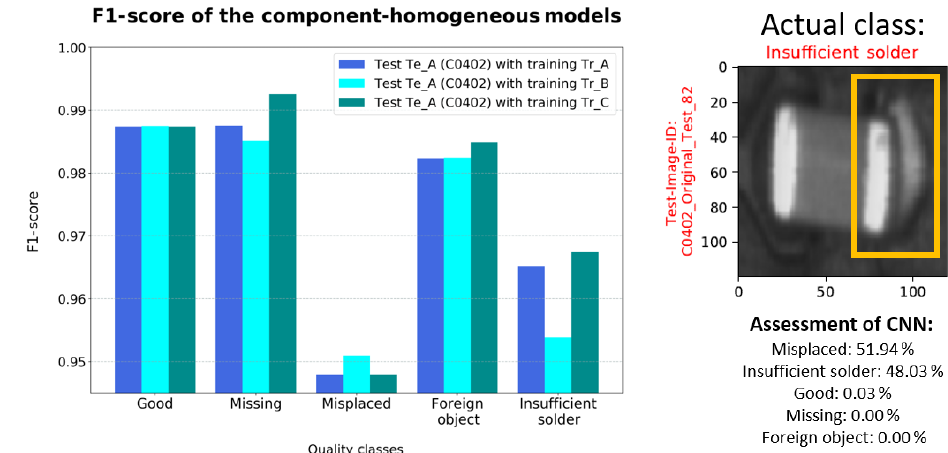
Figure 4. Classification results of test dataset Te_A with the homogeneous training datasets and prediction result of a misplaced